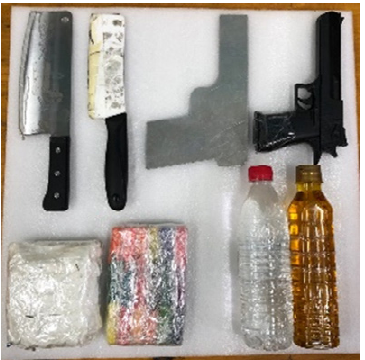
Figure 9. Simulated threats in our study. In the first row, from left to right, they are a metallic knife, a ceramic knife, a metallic gun, and a plastic gun. The second row is washing powder, plasticine, water, and oil.